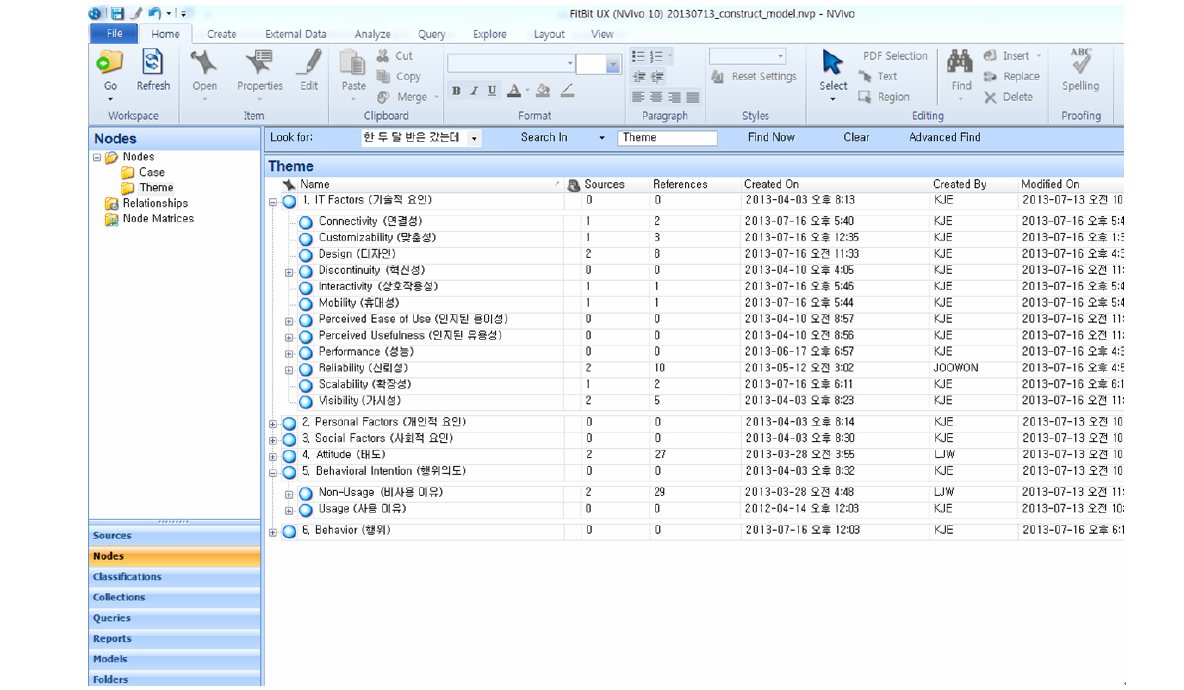
Figure 1. Screen capture of the constructs coding using NVivo qualitative analysis